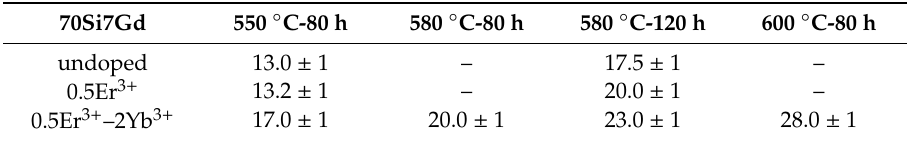
Table 2. Nanocrystals medium size, in nm, of undoped, Er 3+ -doped and Er 3+ –Yb 3+ -codoped 70Si7Gd GCs treated at different temperatures and dwelling times.